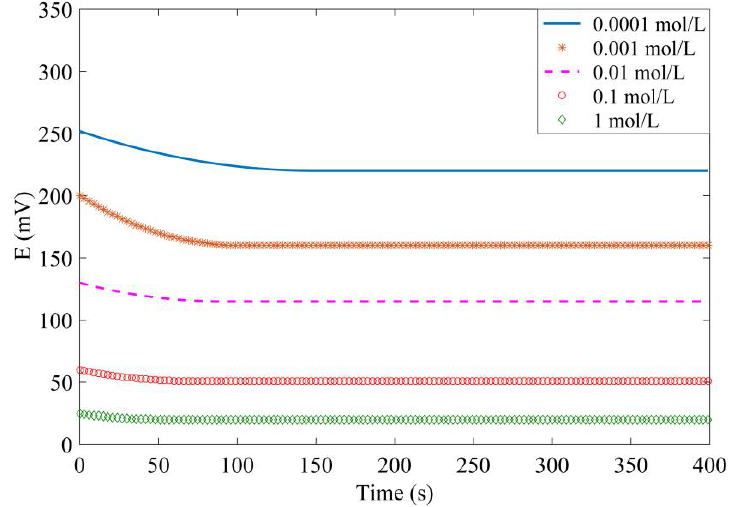
Figure 12. Measured potential variation over time.